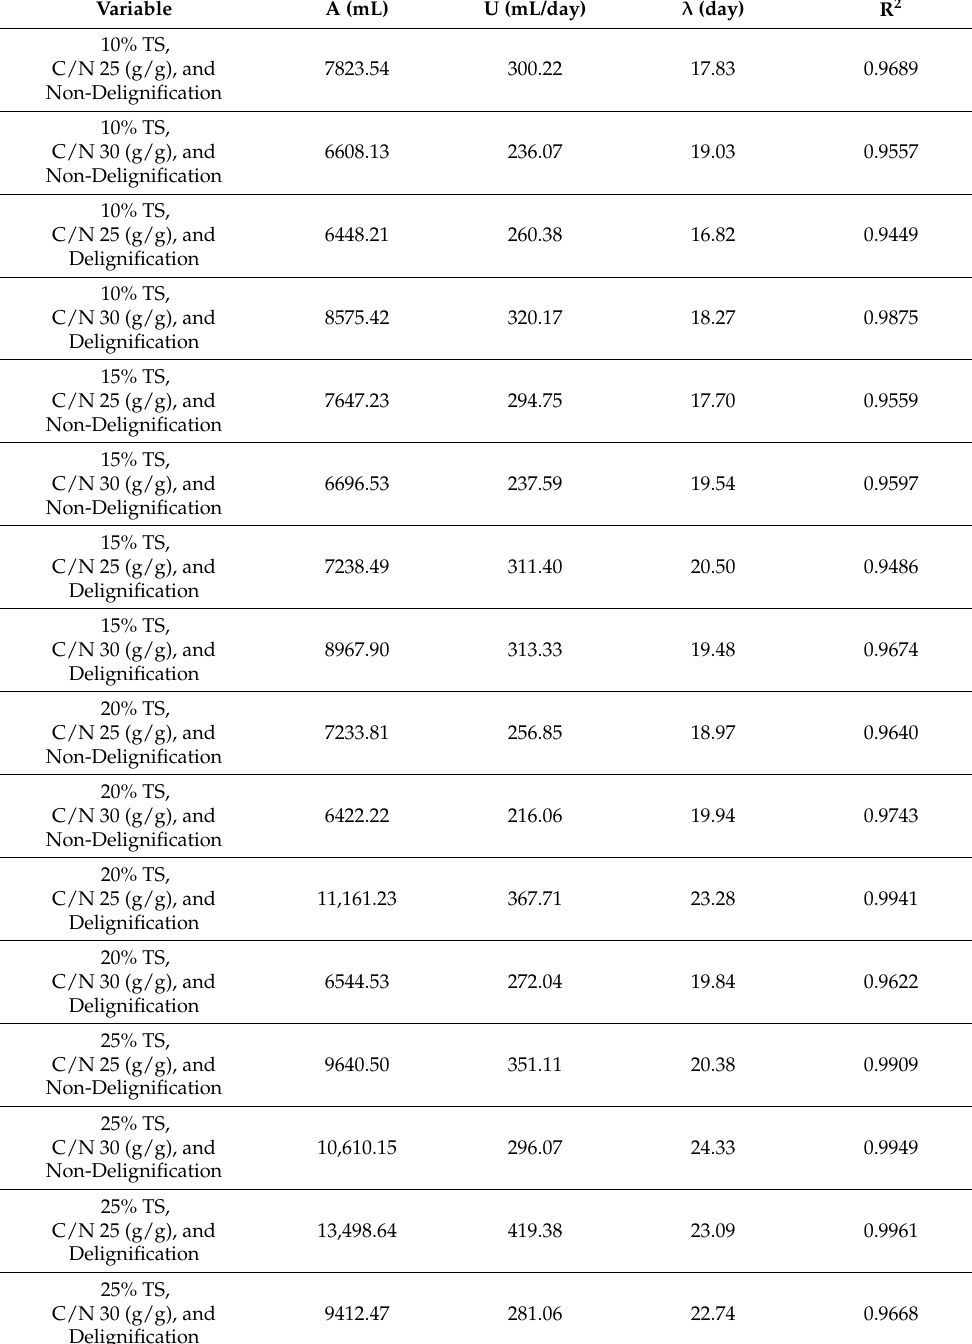
Table 2. Comparison of kinetic modification using the Gompertz